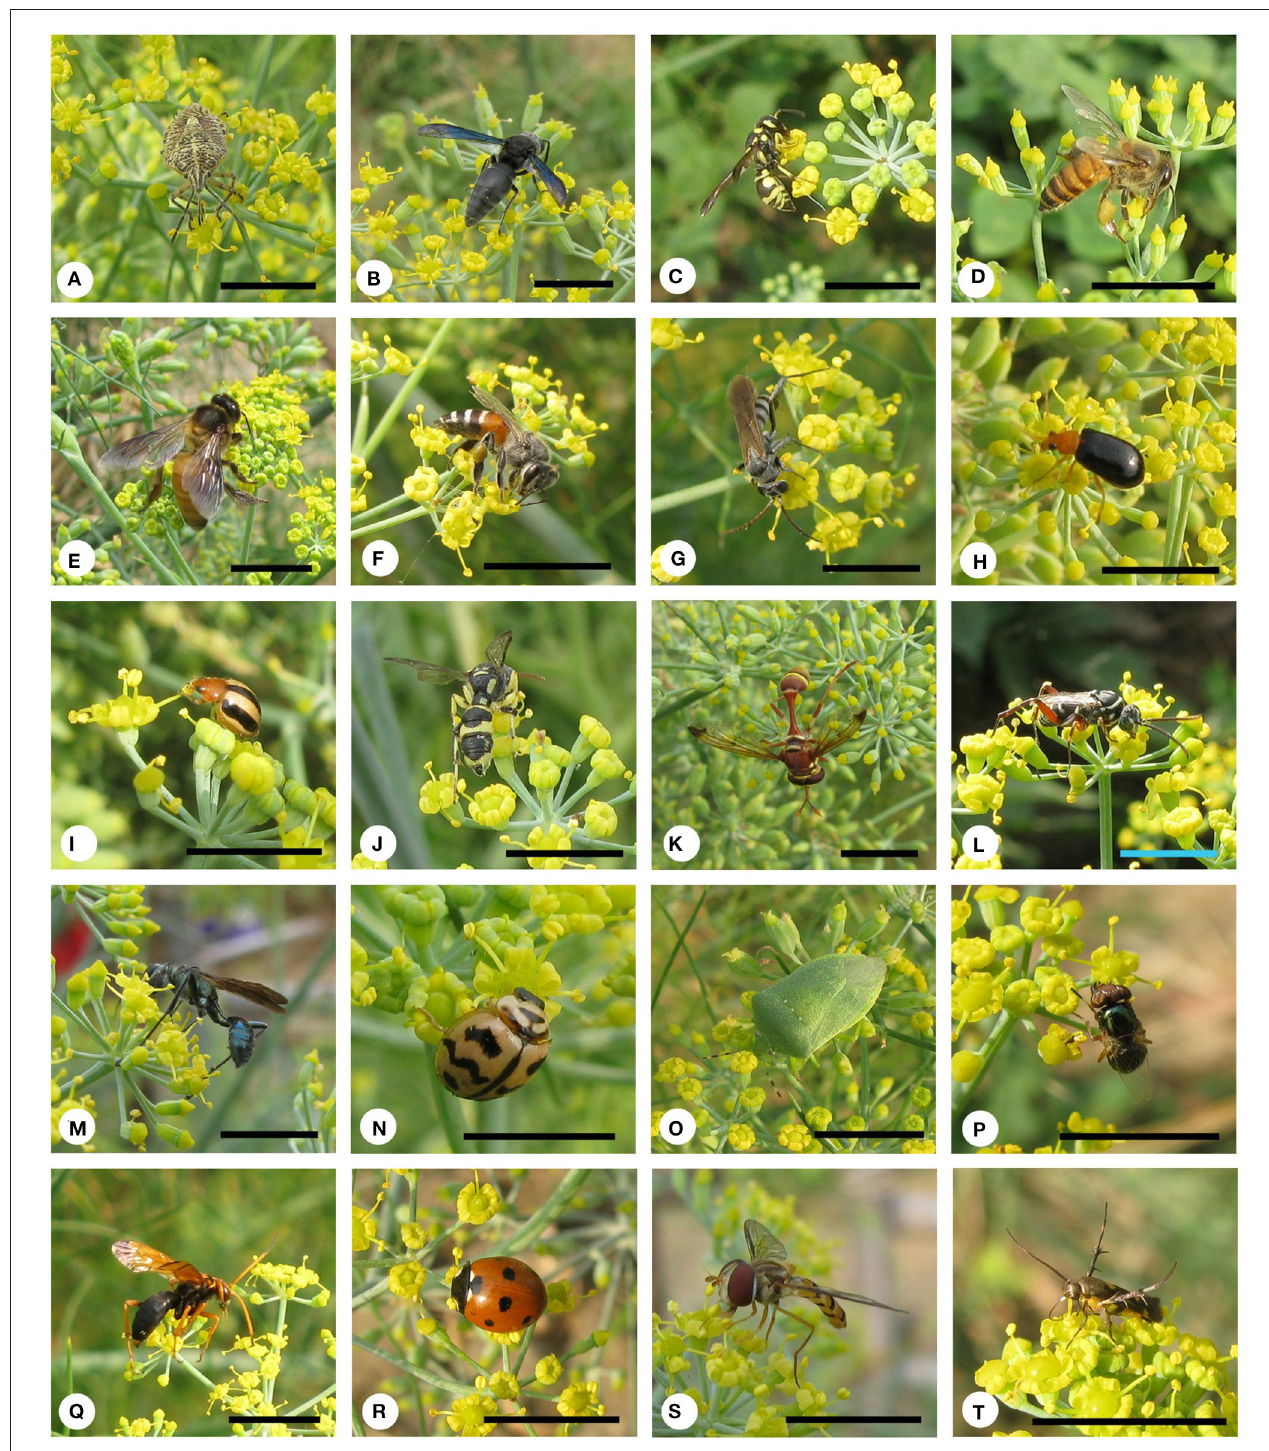
FIGURE 2 | Floral visitors of fennel in West Bengal. (A) Agonoscelis nubila , (B) Allorhynchium metallicum , (C) Antepipona ovalis , (D) Apis cerana , (E) Apis dorsata , (F) Apis florea , (G) Aporinellus sexmaculatus , (H) Aulacophora frontalis , (I) Brumoides suturalis , (J) Cerceris rybyensis , (K) Ceriana eumenioides , (L) Ceropales maculata , (M) Chalybion bengalense , (N) Cheilomenes sexmaculata , (O) Chinavia hilaris , (P) Chlovorhinia exempta , (Q) Cryptocheilus sp., (R) Coccinella septumpunctata , (S) Episyrphus balteatus , and (T) Eretmocera impactella . Scale bar = 10mm.